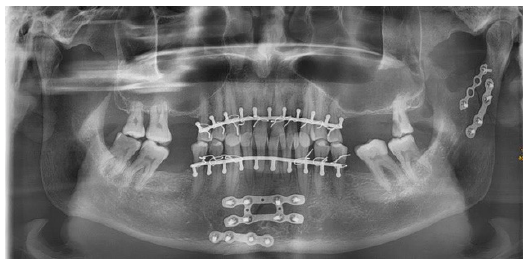
Figure 5. Visualization of the application of the symphysis plate.